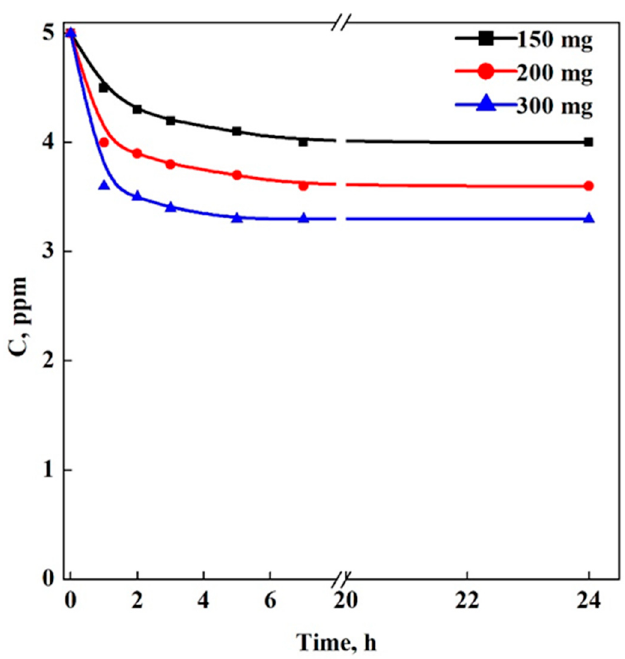
Figure 4. Adsorption kinetics of cryogel samples analyzed in the experiments of Set C (Cryogels) performing a batch adsorption (T = 25 ◦ C, rpm = 200, λ = 591) and using three different amounts of performing a batch adsorption (T = 25 °C, rpm = 200, λ = 591) and using three different amounts of cryogels: 150 mg (black line), 200 mg (red line) and 300 mg (blue cryogels: 150 mg (black line), 200 mg (red line) and 300 mg (blue line).